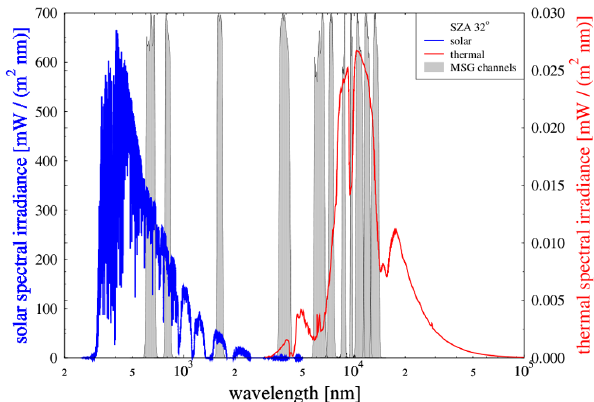
Fig. 1. MSG/SEVIRI spectral channels and an example spectrum of reflected solar and outgoing longwave irradiance.